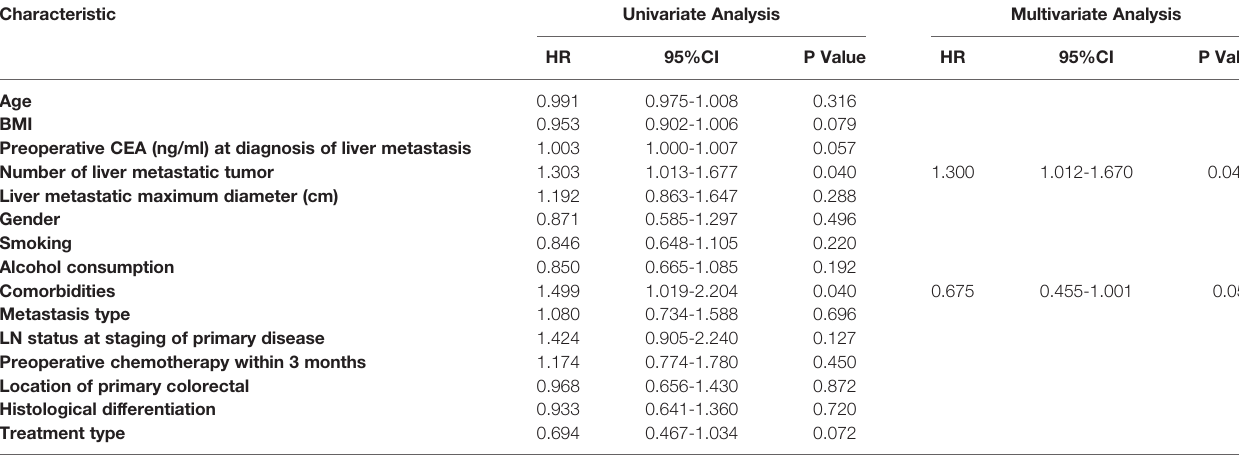
TABLE 4 | Cox Survival Analysis of Predictors DFS in the Whole Population. Characteristic